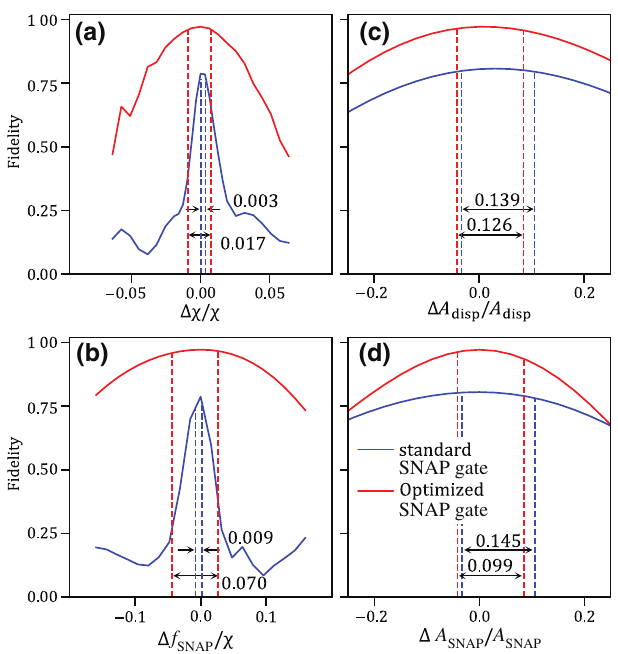
FIG. 5. Simulated fidelities for optimized and “standard” SNAP gates versus the same calibration parameters as in Fig. 4. The distance between the dashed lines represents the parameter span where the fidelity is within 1% of the maximum. Optimized SNAP gates are identical to those in Fig. 4, while “standard” SNAP gates are a superposition of 4- μ s-long pulses centered at photon-number-dependent qubit frequencies